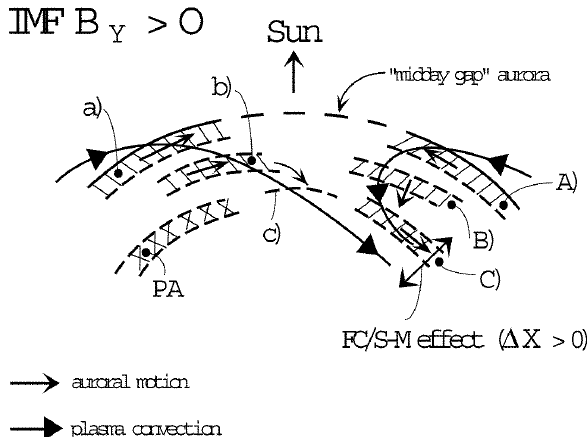
Figure 24 Fig. 24. Schematic illustration of the spatio-temporal evolution of the auroral brightening events. Successive activations of auroral forms in the pre- and postnoon sectors are marked A-B-C and a- b-c, respectively. Auroral motions are indicated by arrows. Polar arc on the dusk side of the polar cap is marked PA. Plasma convec- tion streamlines are superimposed. Plasma flow channel (FC) and associated Svalgaard-Mansurov effect ( 1 X > 0) are marked. set of polar rain started immediately after satellite F13 exited a regime of polar cap arc precipitation on the postnoon side. The latter precipitation (PA) is that causing the postnoon sec- tor auroral form marked (c) in Fig. 2 and crosshatched (PA) in Fig. 24. The associated magnetic deflection is called DPY2 in Fig.